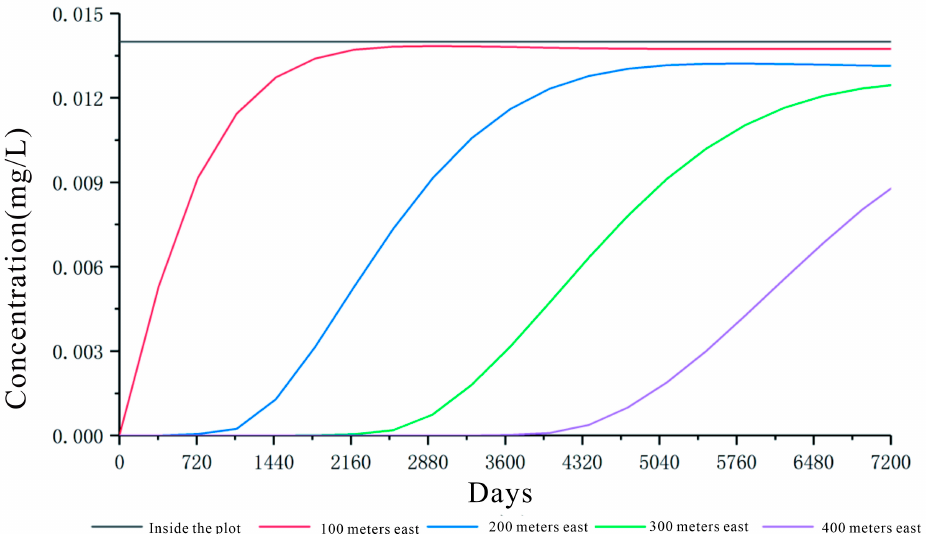
Figure 10. Pb concentration variation curve.